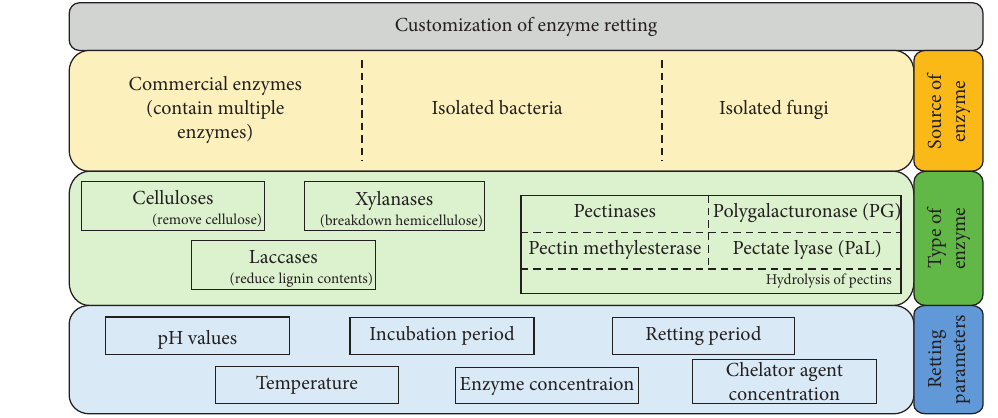
Figure 10: Customization of enzyme retting.